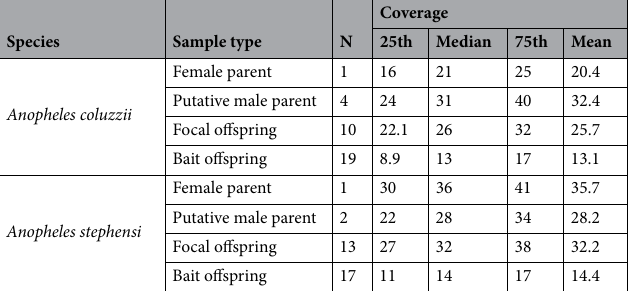
Table 1. Whole genome sequencing coverage results for each sample categorization. Number of samples (N) and whole genome coverage results for parents and offspring types (focal and bait) for A. coluzzii and A. stephensi. 25th 25th percentile, 75th 75th